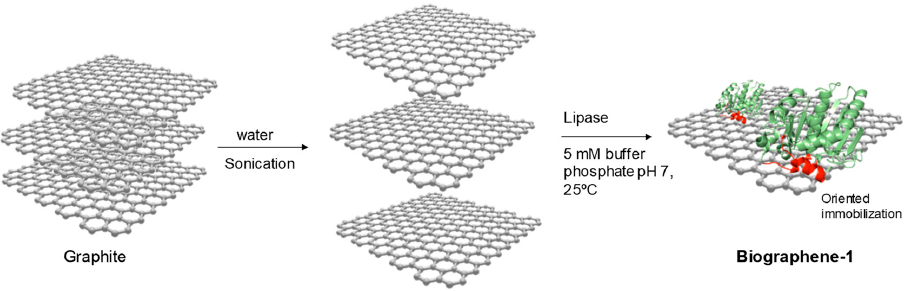
Figure 4. Schematic representation of biographene-1 preparation by Method 3.